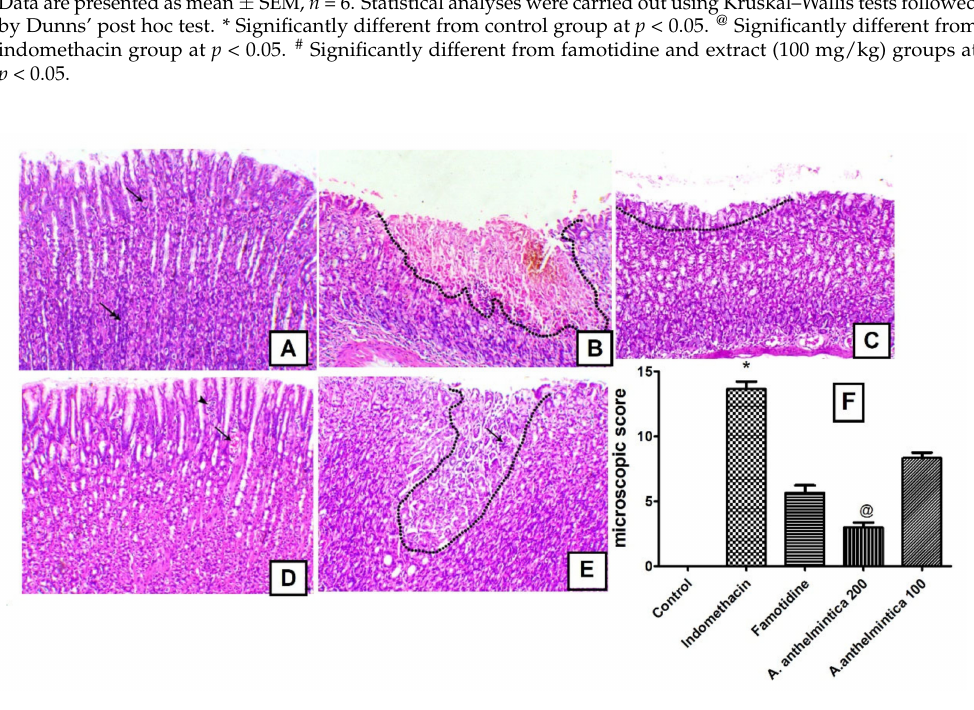
Figure 3. A photomicrograph of histopathological changes: ( A ) Control with normal gastric mucosa (arrow indicates normal parietal cells and double arrow indicates normal surface mucous cells); ( B ) indomethacin group showing severe degree of coagulative necrotic changes within the gastric mucosa (area above the dotted line) accompanied with deposition of acid hematin (arrow) and inflammatory cell infiltration (arrowheads); ( C ) famotidine-treated group showing marked decreases in the degenerative and necrotic changes within the gastric mucosa (area above the dotted line); ( D ) A. anthelmintica extract (200 mg/kg)-treated group showing a marked decrease in the degenerative changes within gastric glands (arrow indicates mild congestion of the gastric capillaries) and few lymphocytes within the surface mucosal lining (arrowhead); ( E ) A. anthelmintica extract (100 mg/kg)- treated group showing foci of degenerative gastric mucosa (area above the dotted line) revealing few necrotic gastric glands (arrow)), H&E, 100 × , bar = 100 µ m. ( F ) Microscopic scores in gastric tissues of rats of different experimental groups. Values are mean ± SEM from 6 samples using Kruskal–Wallis followed by Dunn’s post hoc test. * p < 0.05, compared with control; @ p < 0.05, compared with